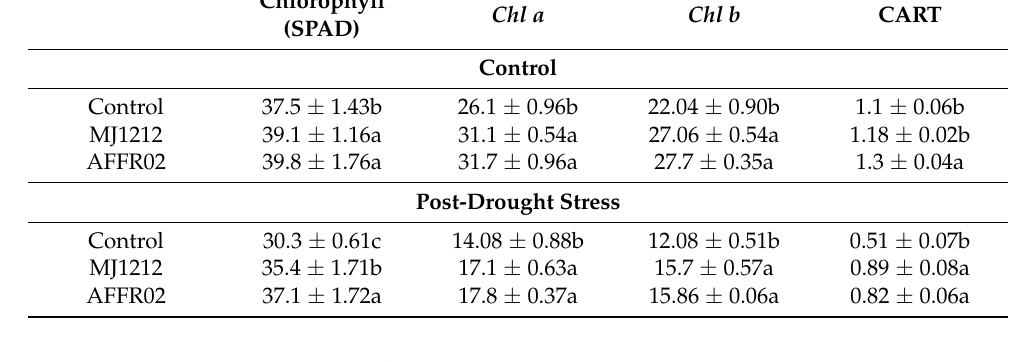
Table 2. Effect of isolate AFFR02 and MJ1212 on chlorophyll content (SPAD), chlorophyll A ( Chl a ), stress. Each value in the table is the mean ± standard deviation of three replicates. Mean in columns